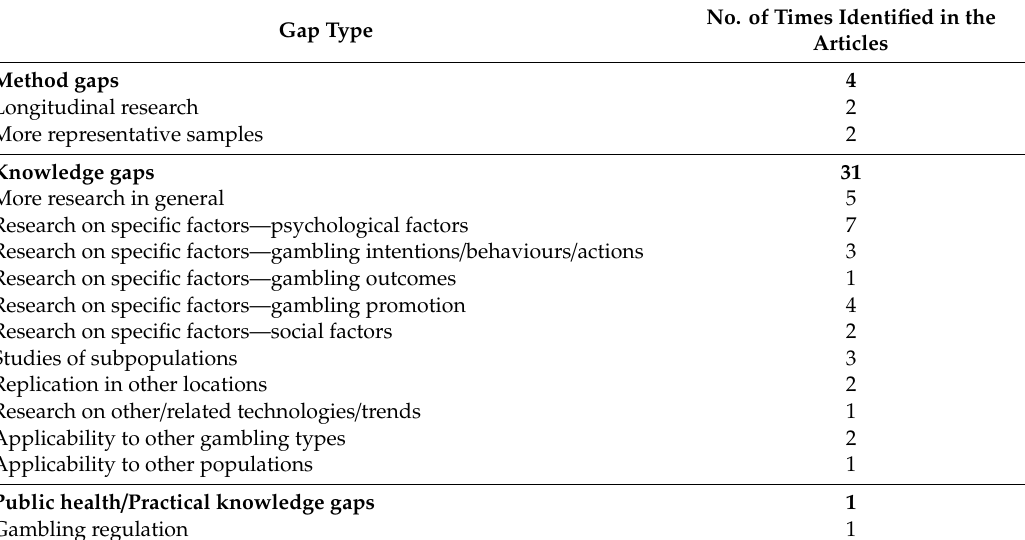
Table 5. Sports betting